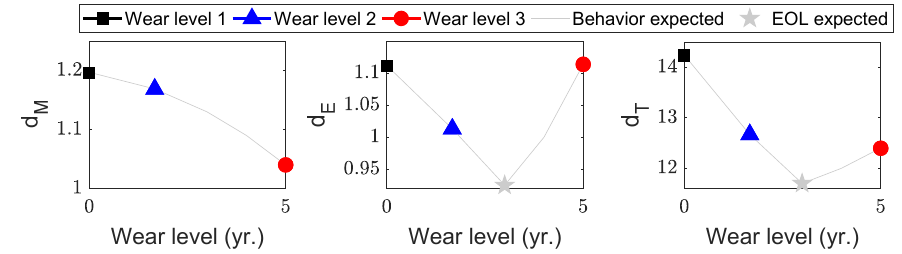
( b ) Figure 11. Degradation feature with correction factor using Equations (2)–(4): ( a ) barrier screw; ( b ) Maddock screw.